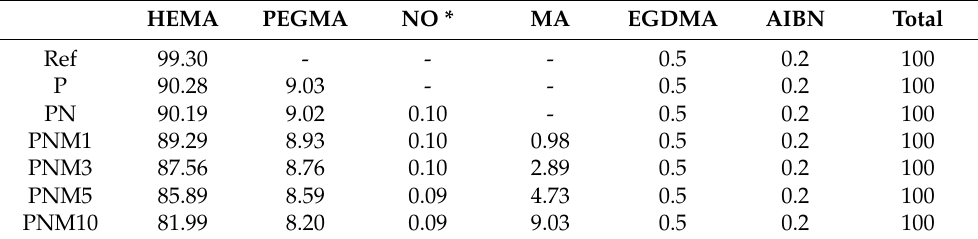
Table 1. Percent composition of samples (unit: